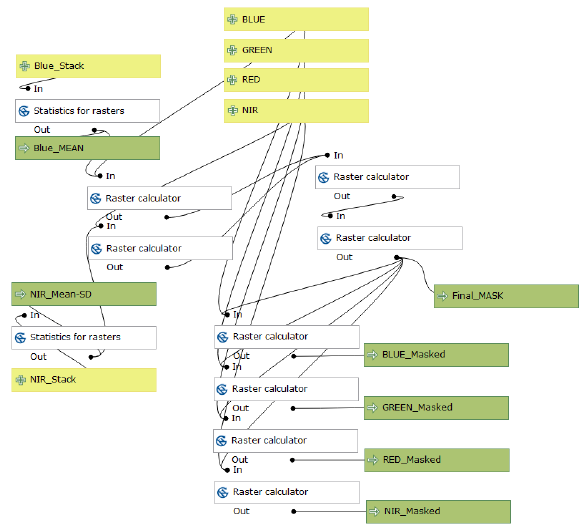
Figure 5. Script model implemented in QGIS for the automatic masking